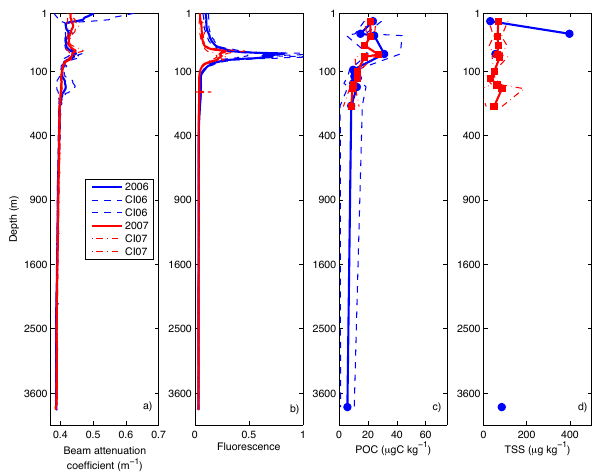
Fig. 4. As in Fig. 2 but for the eastern Northwind Ridge slope re- gion. The upper 1600m are shown to include all attenuation fea- tures and bottle samples.The value on the horizontal axis for beam attenuation coefficient is about half of the value in Figs. 2a and 3a.